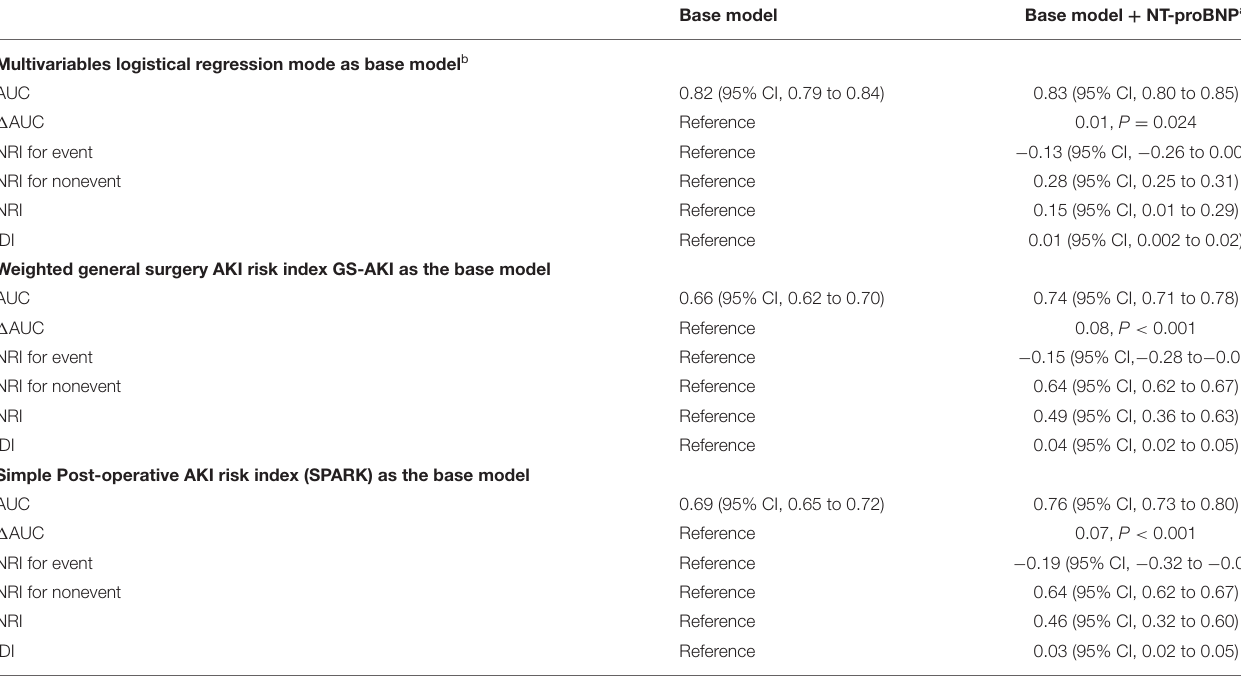
TABLE 4 | Comparison of acute kidney injury prediction models with and without pre-operative N-terminal pro-B-type natriuretic